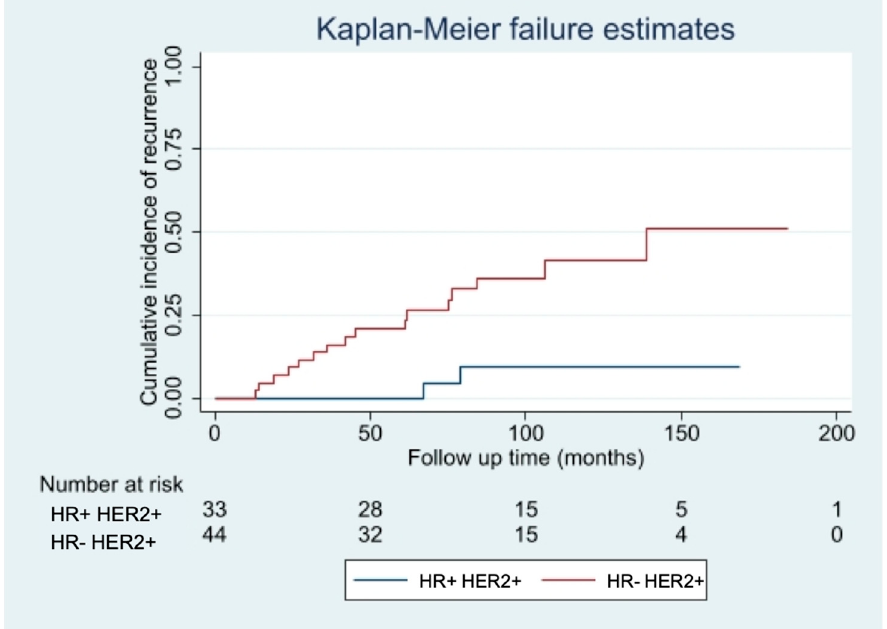
Figure 3. Risk of relapse in patients not treated with Trastuzumab with HR − vs. HR+ tumors.